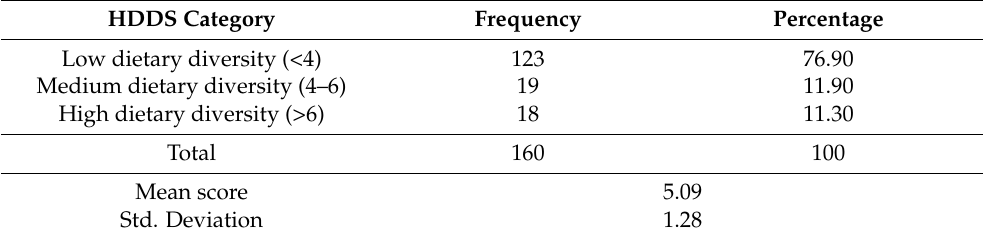
Table 4. Results of the household dietary diversity score of households with children in the Inanda Informal